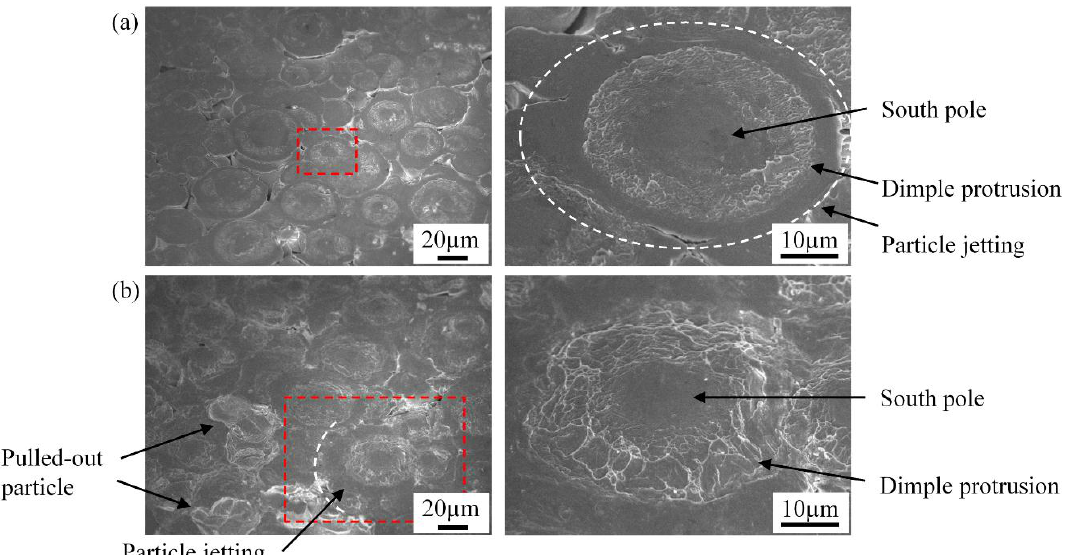
Figure 10. SEM micrographs of the fractured interfaces on the coating side for the coatings deposited at particle velocities of ( a ) 730 and ( b ) 855 m/s, observed under different magnifications at a tilted angle of 45 ◦ . The fractured interfaces of the coatings deposited with the sprayed particles of other impact velocities are shown in Figure S2 (Supplementary